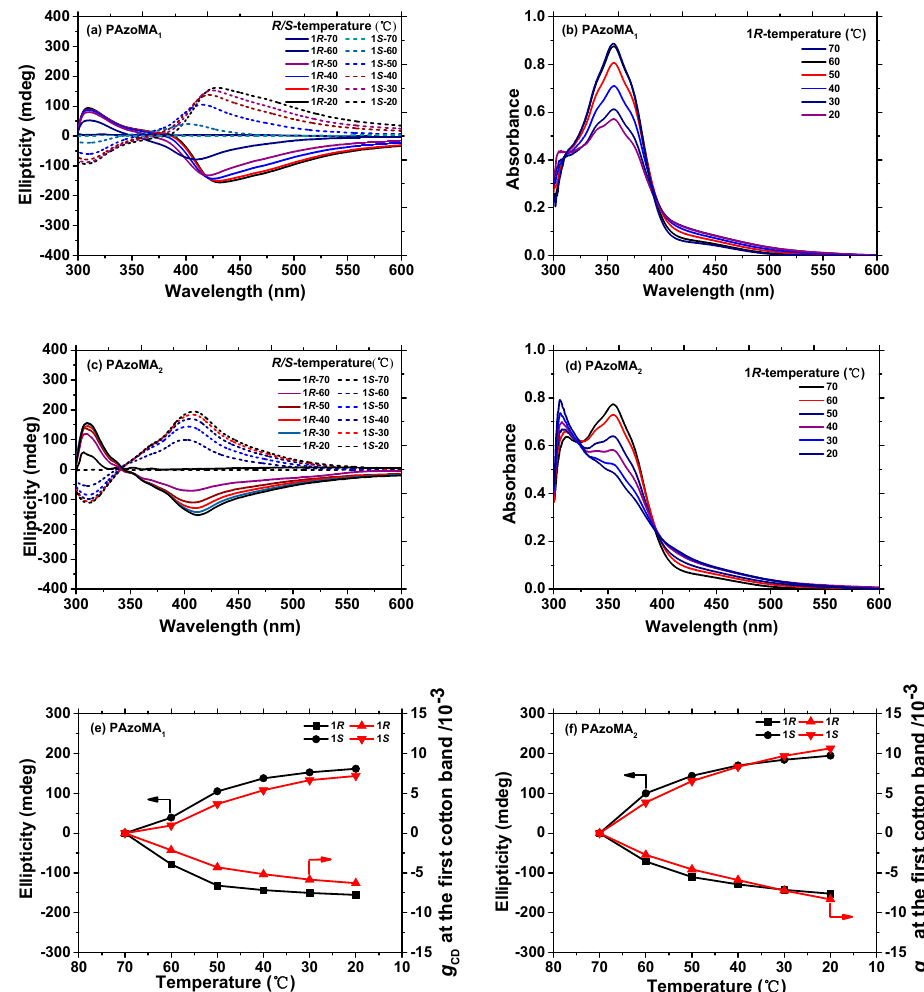
Figure 1. The circular dichroism (CD) ( a , c ), UV-vis spectra ( b , d ) and maximum CD and g CD values ( e , f ) of the side-chain Azo-containing polymer aggregates with the temperature decreasing from 70 °C to 20 °C. ( a , b , e ) stand for PAzoMA 1 , ( c , d , f ) stand for PAzoMA 2 . The concentration of polymer repeating units is 8.42 × 10 − 5 mol L − 1 .